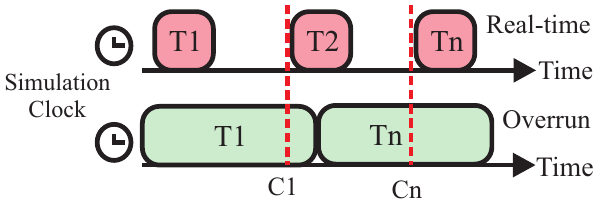
Figure 2. RT simulation